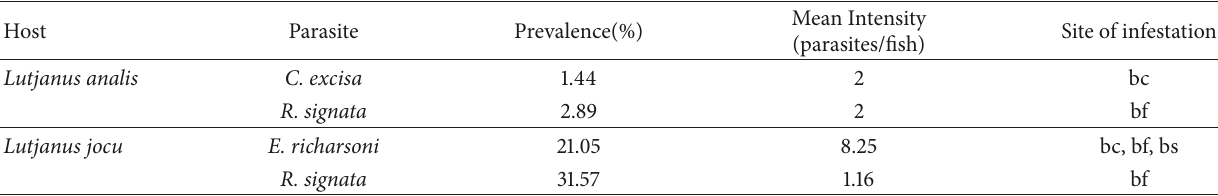
Mean Intensity Site of infestation (parasites/fish)